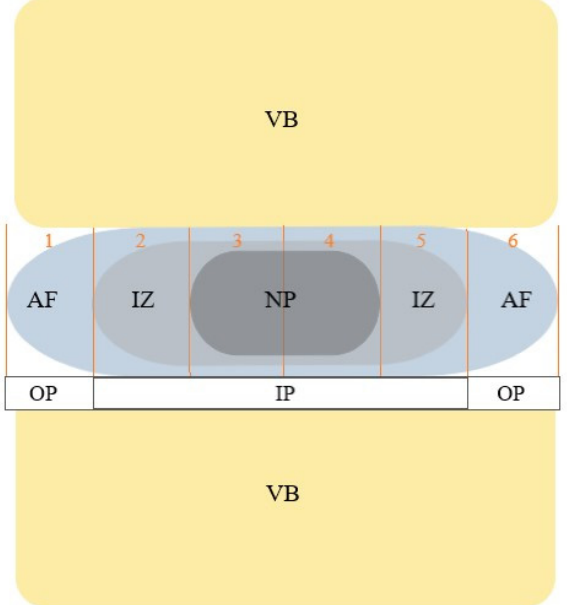
Figure 2. Scheme of the intervertebral disc (sagittal plane). The IVD consists of the nucleus pulposus (NP), the intermediate zone (IZ) and the anulus fibrosus (AF). The inner part (IP) contains the NP and IZ and the outer part (OP) contains the AF. The red lines and numbers 1 to 6 describe the different ROIs for T2 analysis of the IVD. The numbers 1 and 6 represent ROI 1 and ROI 6 and are classified as AF. The NP describes the inner part of the IVD as ROI 3 and ROI 4 and is marked in this figure as numbers 3 and 4. The IZ in between the AF and NP is shown by numbers 2 and 5 and displays ROI 2 and ROI 5.